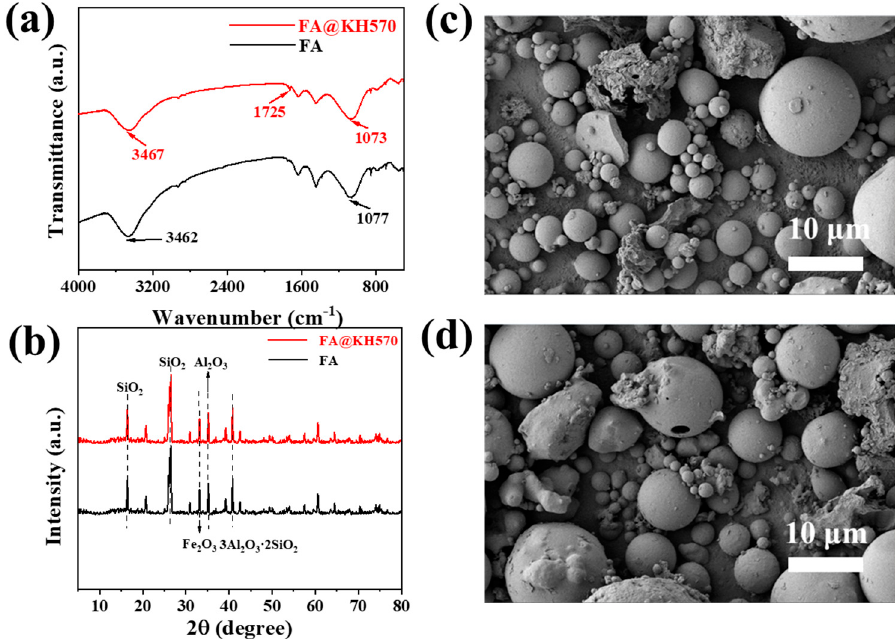
Figure 3. ( a ) FTIR of FA and FA@KH570. ( b ) XRD patterns of FA and FA@KH570. ( c ) and ( d ) SEM micrograms of FA and FA@KH570.